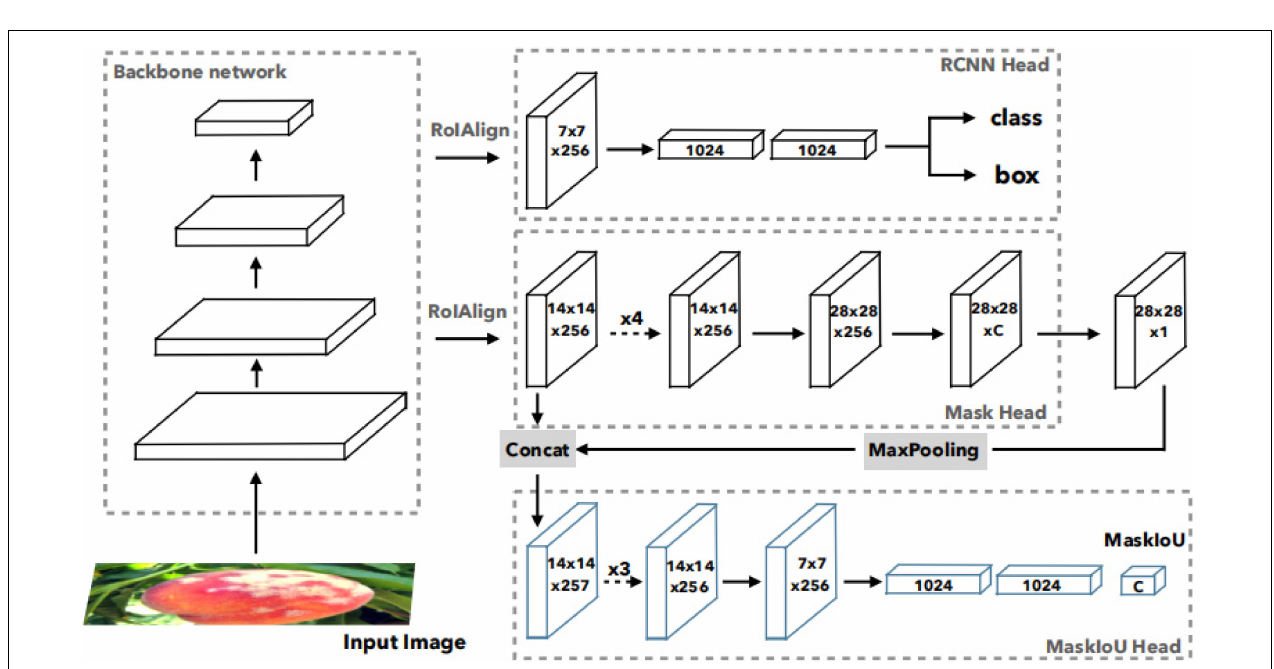
FIGURE 4 | Network architecture of Mask Scoring R-CNN (Huang et al.,